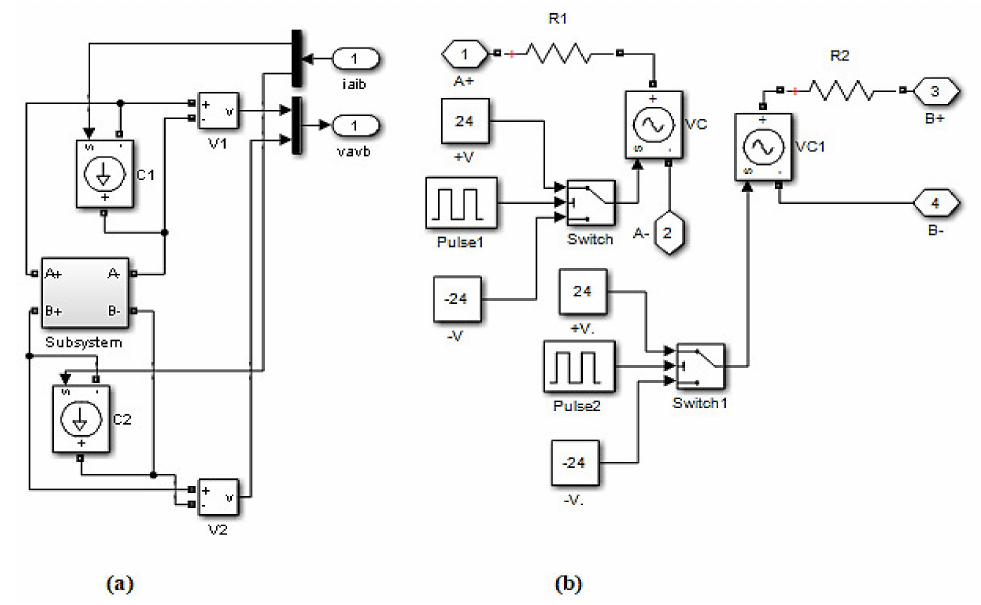
Figure 5. ( a ) Content of the “Driving block” in Figure 4, ( b ) Content of the “subsystem” in ( a